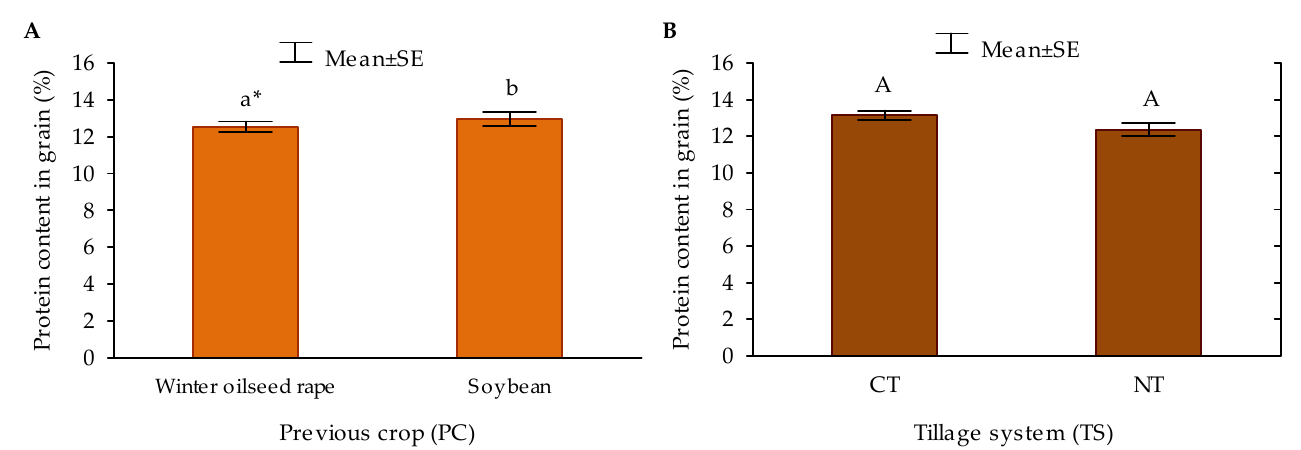
Figure 5. Total protein content in winter wheat grain depending on previous crop ( A ) and tillage system ( B ) (mean for 2014–2017). CT—Conventional tillage; NT—No-tillage. * Different letters denote significant differences ( p ≤ 0.05). The same letter means not significantly different values. The lowercase letters refer to previous crops (PC); the capital letters refer to tillage systems (TS).